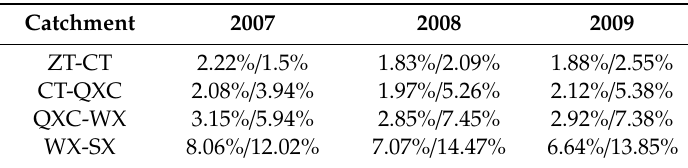
Table 6. Ratio of intermediate flow to the gaged inflow.